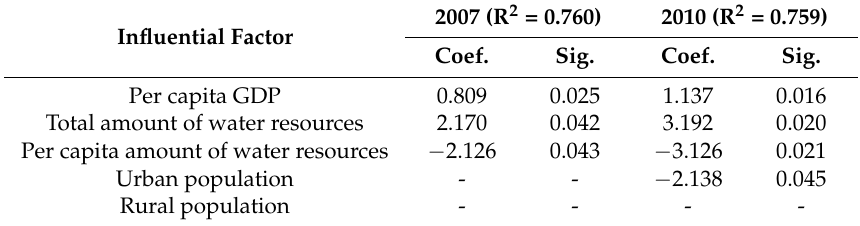
Table 3. Regression analysis for regional WF for the years, 2007 and 2010, at a 95% confidence level. 2007 (R 2 = 0.760) 2010 (R 2 = 0.759) Influential Factor Coef. Sig. Coef. Sig. Per capita GDP 0.809 0.025 1.137 0.016 Total amount of water resources 2.170 0.042 3.192 0.020 Per capita amount of water resources − 2.126 0.043 − 3.126 0.021 Urban population - - − 2.138 0.045 Rural population - - - - Note: Coef. = coefficients; and Sig. = Significance